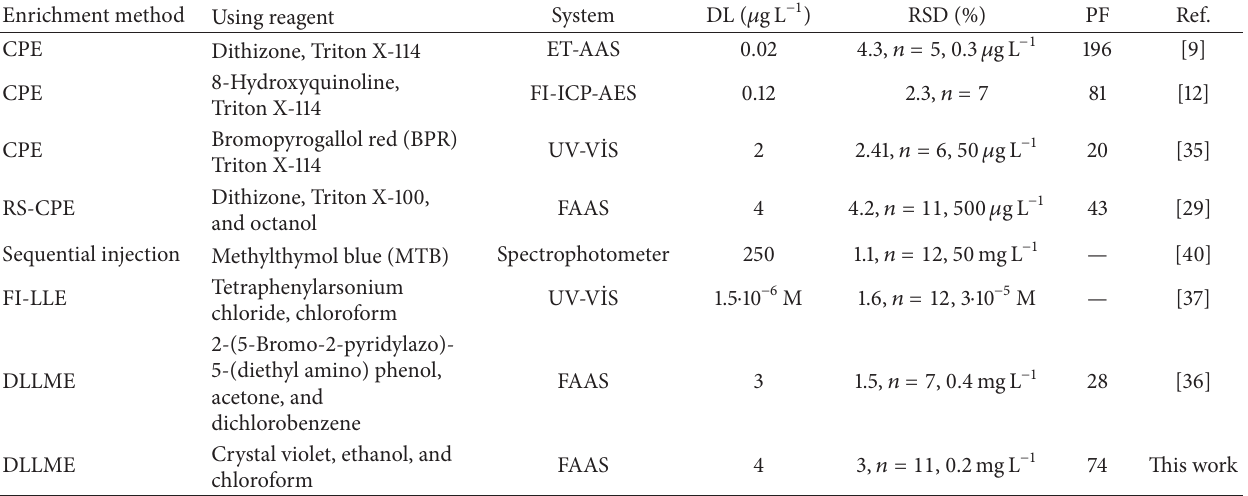
Table 3: Comparison of the characteristic data between recently published works for